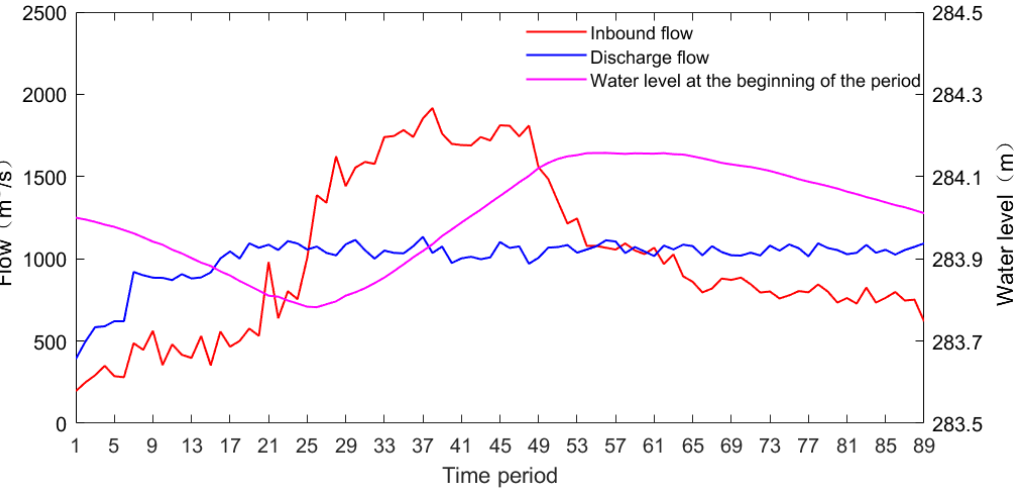
Figure 12. Optimal scheduling results of the second flood with the maximum peak clipping criterion.